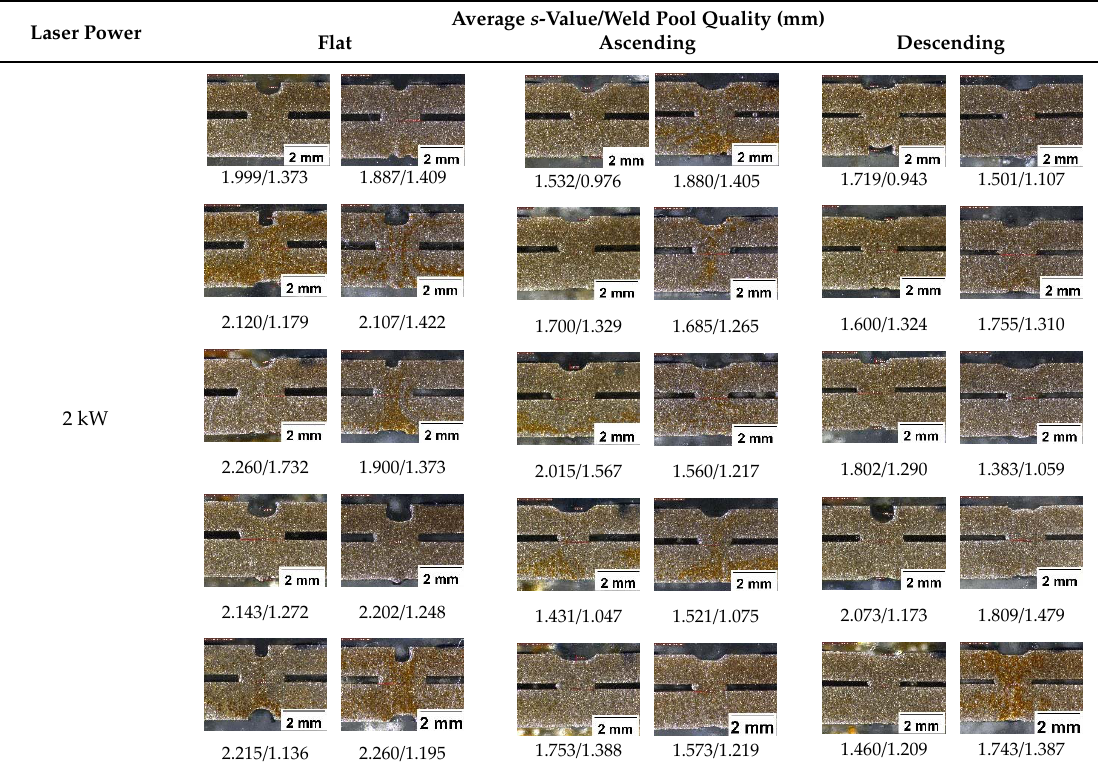
Table 10. The laser welding experimental data of experiment #2-1.